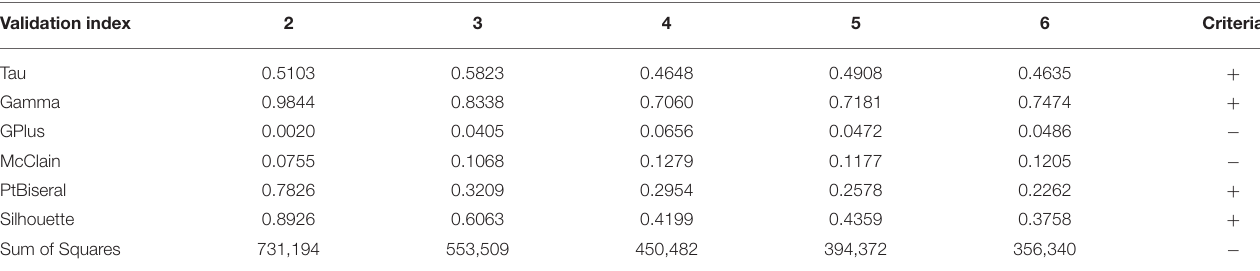
TABLE 3 | ICV indexes obtained for the different number of clusters ( k = 2..6).